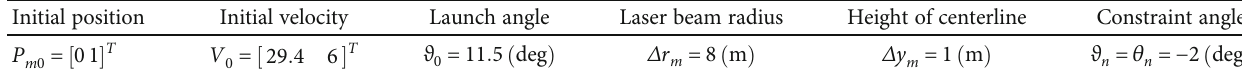
Table 2: Initial munition data.